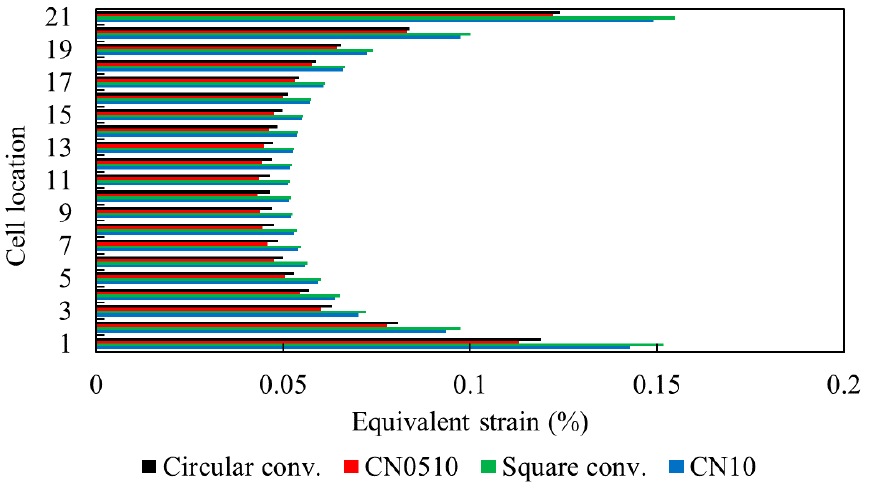
Figure 8. Maximum strain at each cell at the 21-cell stack.